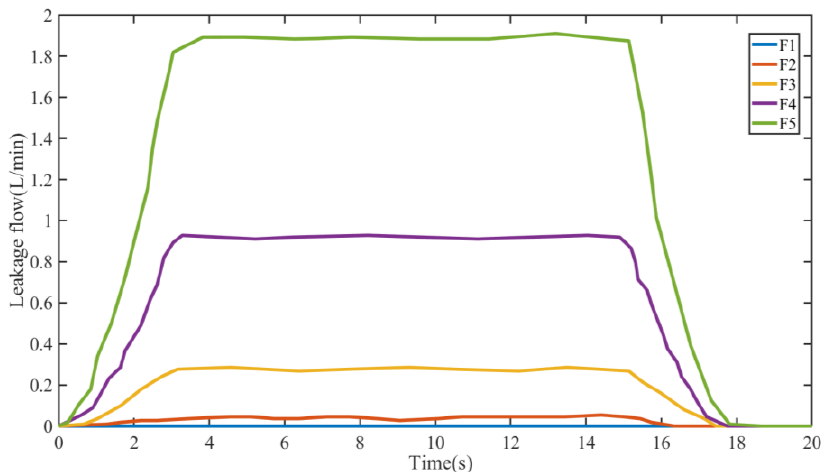
Figure 17. Leakage flow of leakage in the speed regulating valve.